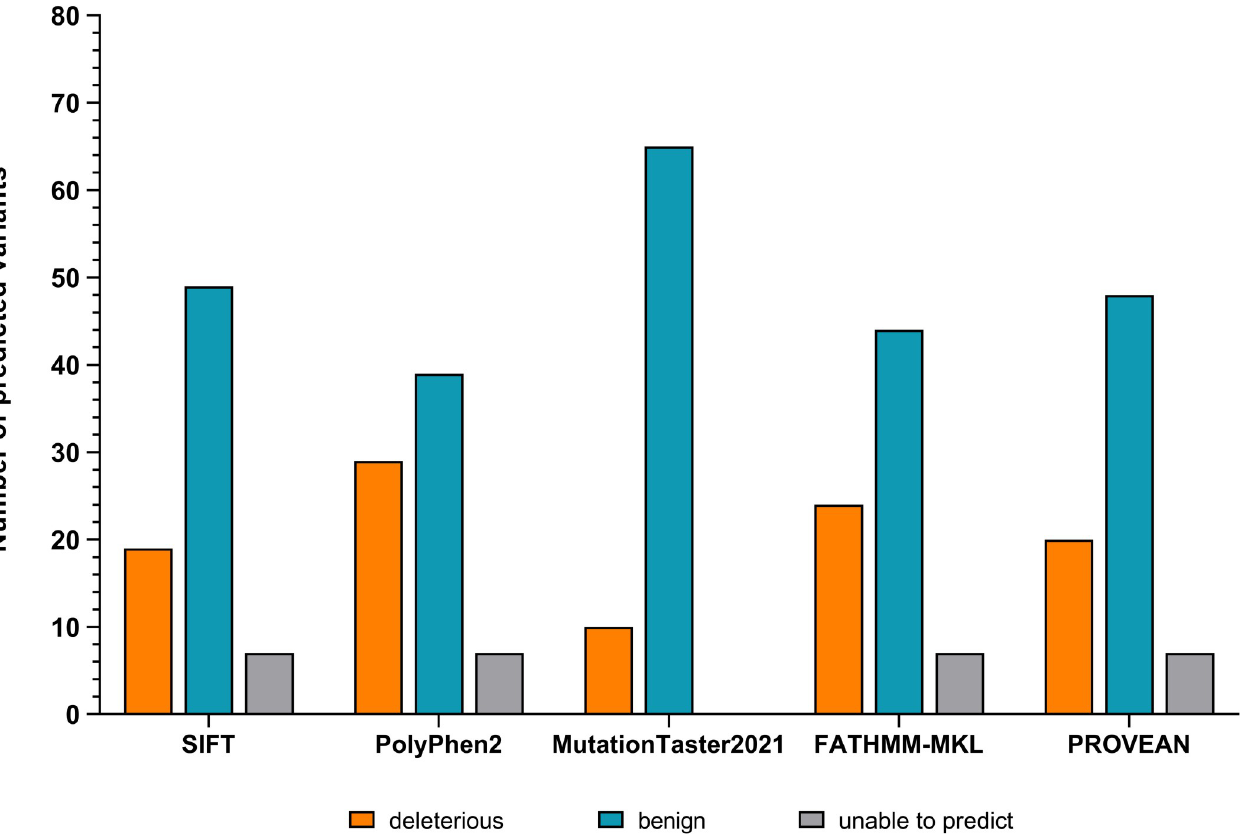
Fig 1. Predictions of the applied in silico tools. All 75 non-synonymous and LoF variants located in LEP were analysed with SIFT, PolyPhen2, MutationTaster2021, FATHMM-MKL and PROVEAN. Unless MutationTaster2021, all tools were unable to predict implications of the seven LoF variants